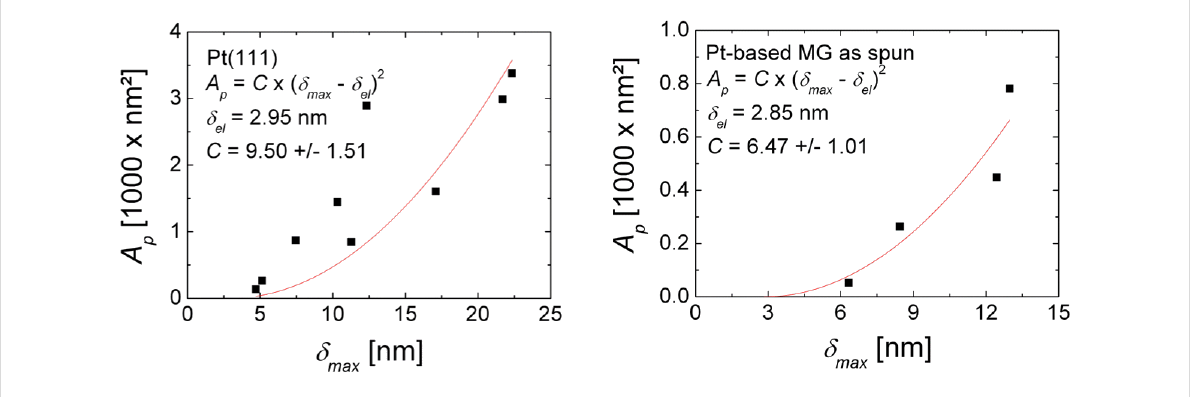
Figure 8: Projected area A p as determined from nc-AFM images as a function of the maximal indentation depth δ max as calculated from force–dis- tance curves for (a) Pt(111) and (b) Pt 57.5 Cu 14.7 Ni 5.3 P 22.5 metallic glass.